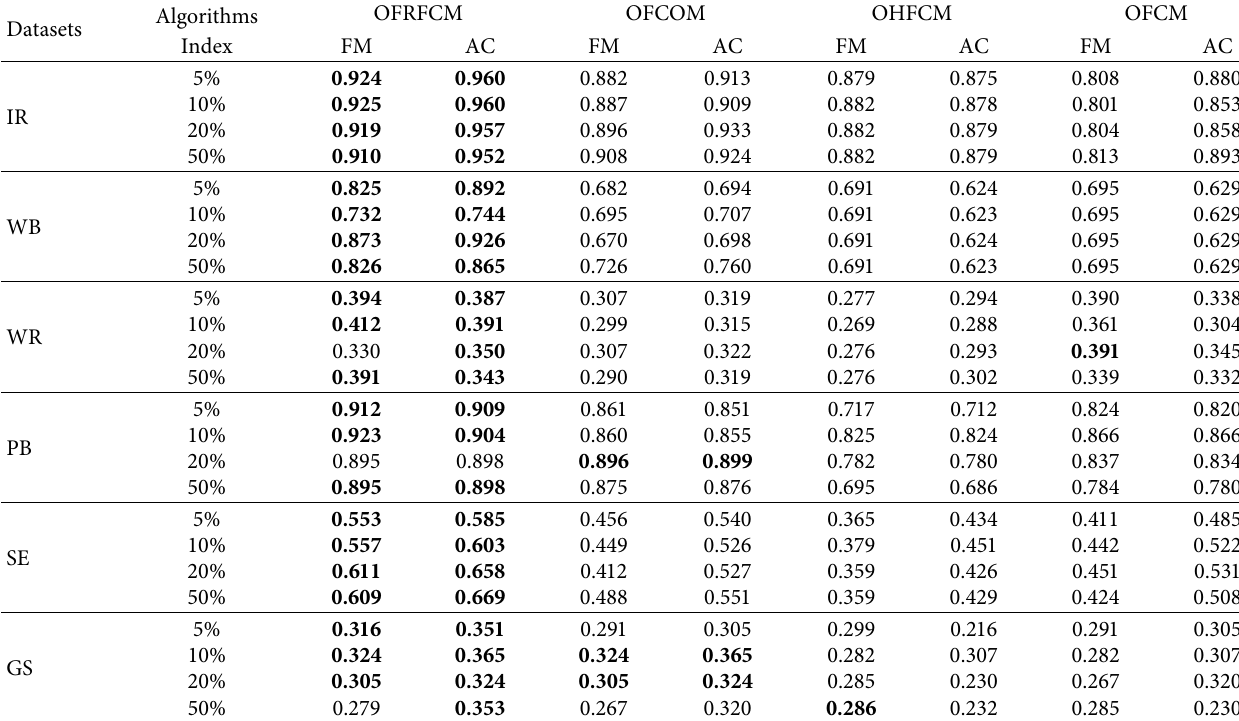
Table 3: Accuracy comparison of four online algorithms.